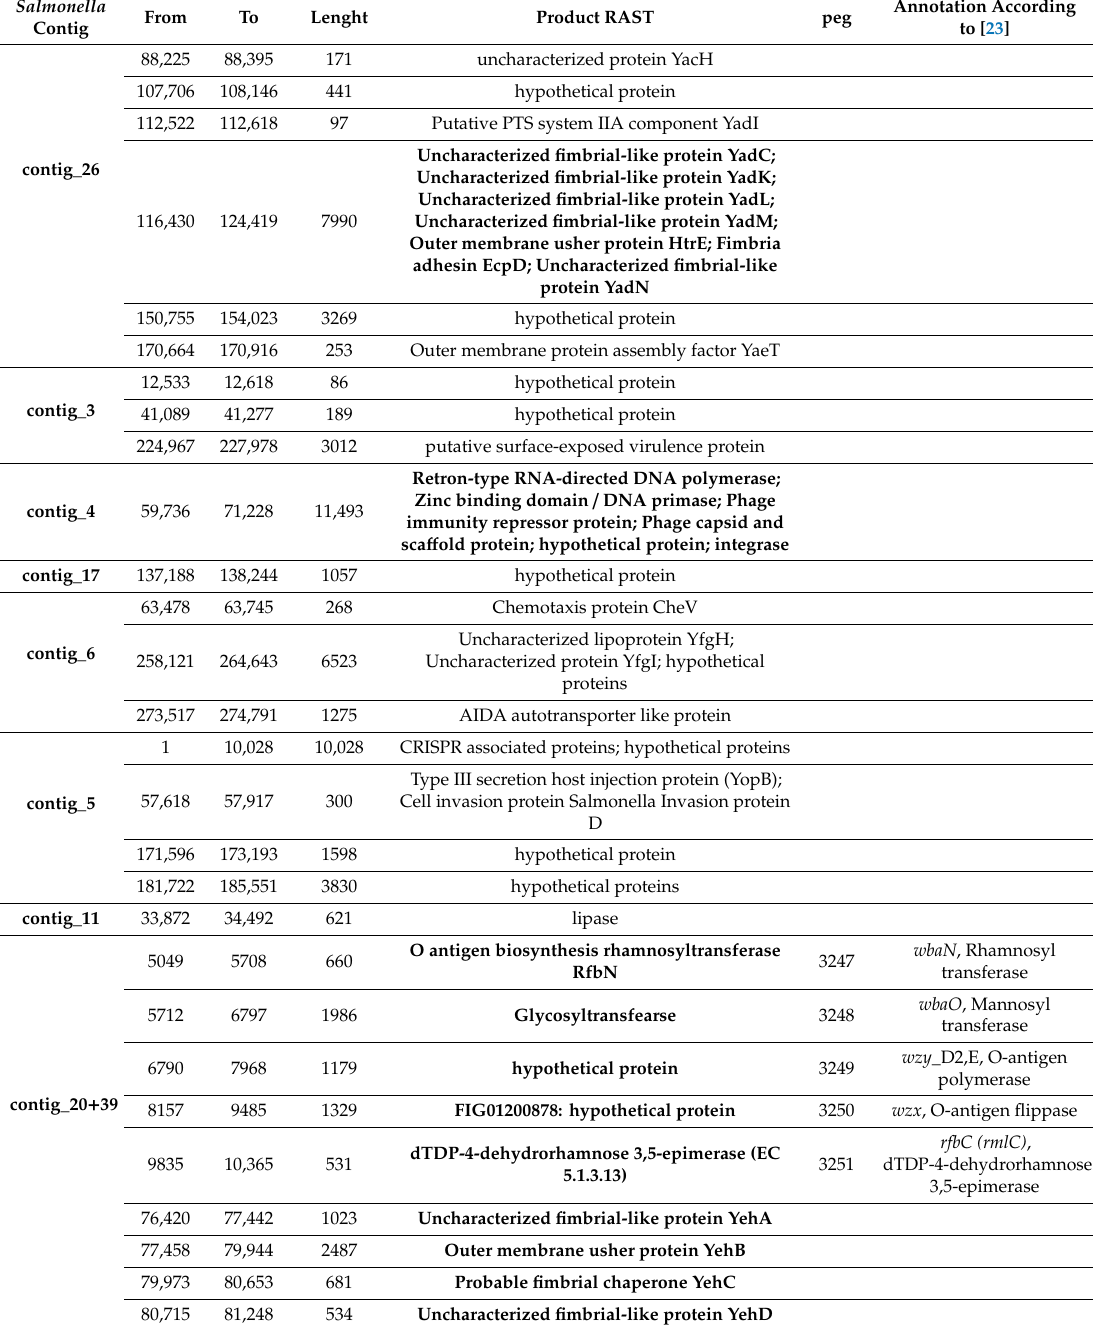
FIG01200878: hypothetical